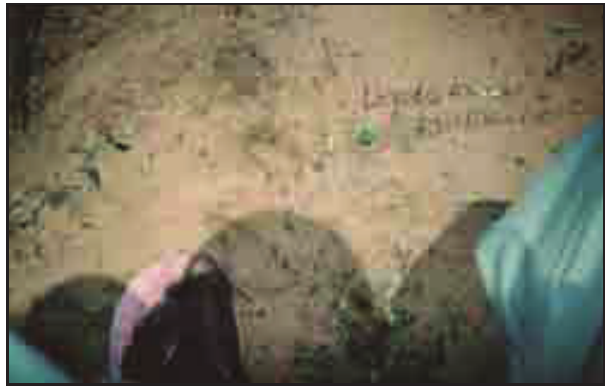
Figure 5: Lerete la ga Rankurunyane